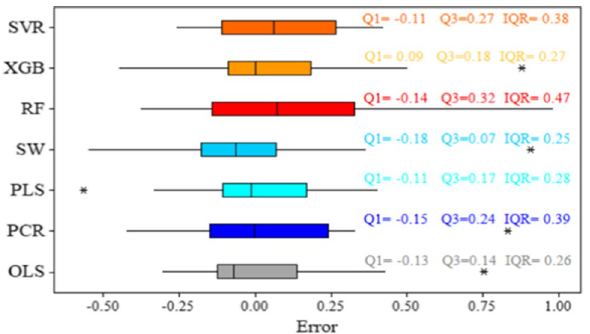
Fig. 6 Boxplots depicting the distribution of SAR estimate errors in the test section for the models under consideration. Q25: lower quar- tile of errors, Q75: upper quartile of errors, IQR: inter-quartile range for each